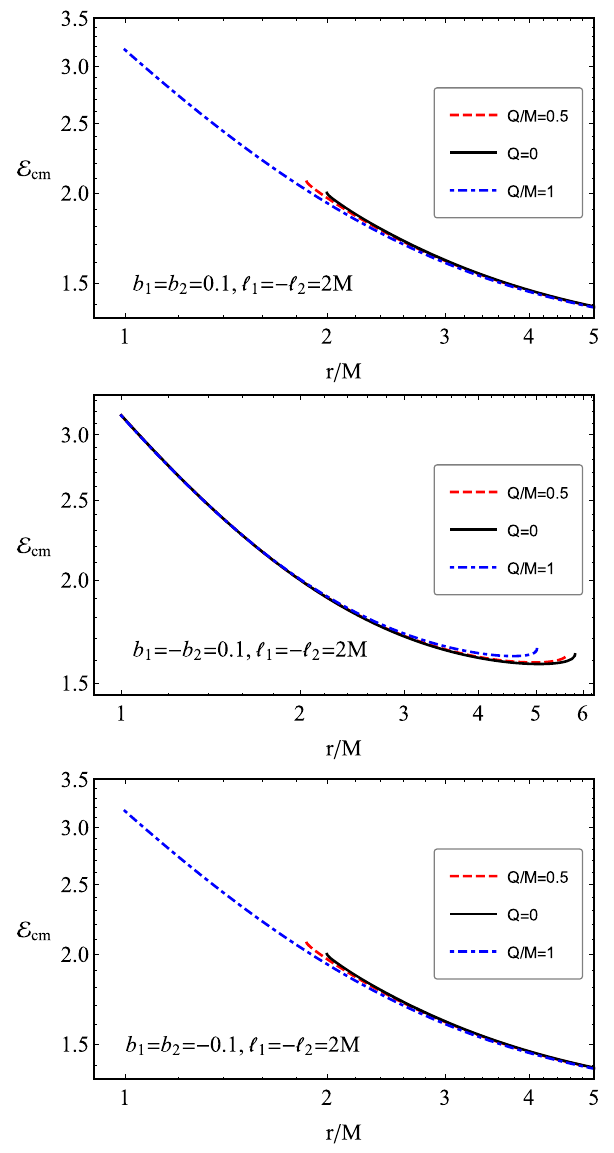
Fig. 13 Dependence of center-of-mass energy of collisions of two magnetized particles with the same initial energy E 1 = E 2 = 1 from the radial coordinate, around electrically charged RN black hole for the different values of the black hole charge for the fixed values of the magnetic coupling parameter of the colliding magnetized